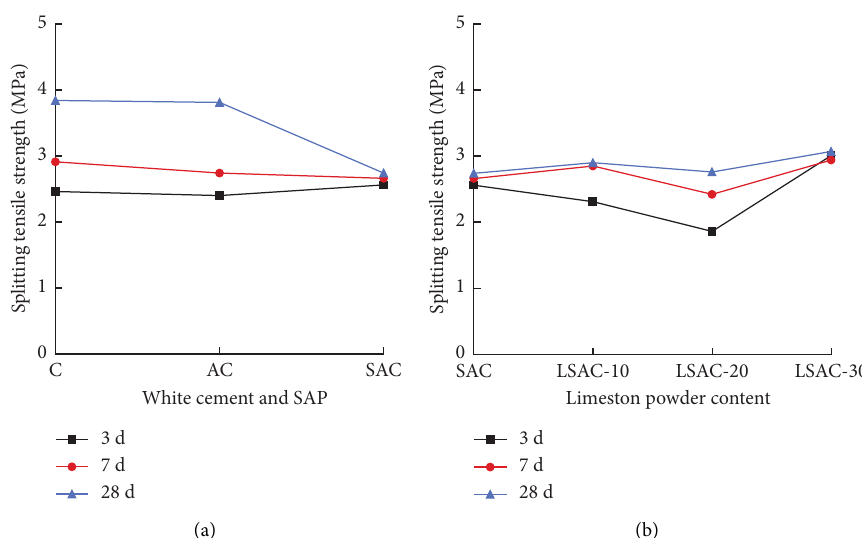
Figure 8: Splitting tensile strength curves of diferent types of fair-faced concrete. (a) Efects of white cement and SAP. (b) Efect of limestone powder